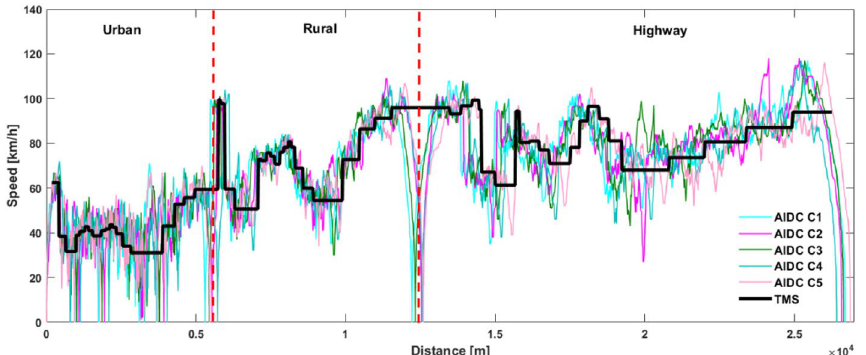
Fig. 5 Average speed values of Istanbul traffic and artificial